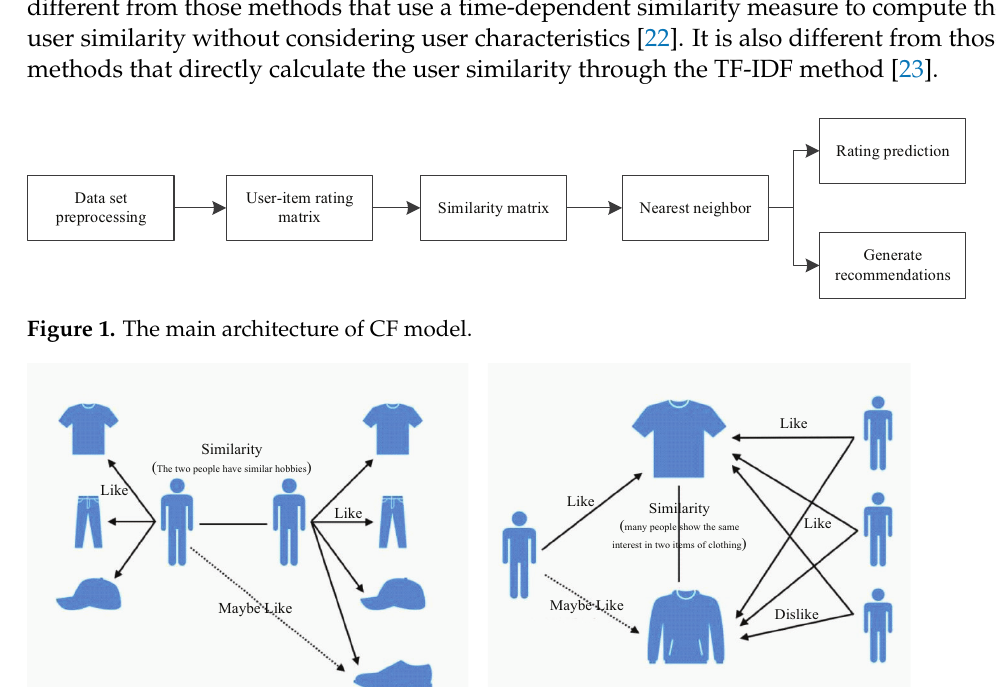
Figure 2. The collaborative filtering algorithms: ( a ) user-based; ( b )